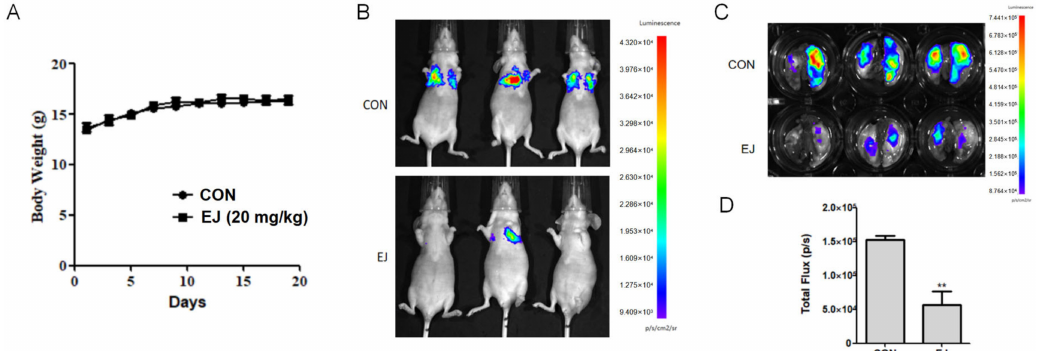
Figure 3. EJ inhibited the metastasis of cancer cells in vivo. ( A ) EJ treatment had no significant effect on the body weight of nude mice. ( B ) Inhibitory effect of EJ on cancer cell metastasis in nude mice was evaluated by in vivo imaging. ( C ) Anatomical lung extraction and in vivo imaging of cancer cell metastasis in the lung. ( D ) The total fluorescence intensity of lung cancer cells was significantly decreased in the EJ-treated group compared to the control group (** p <